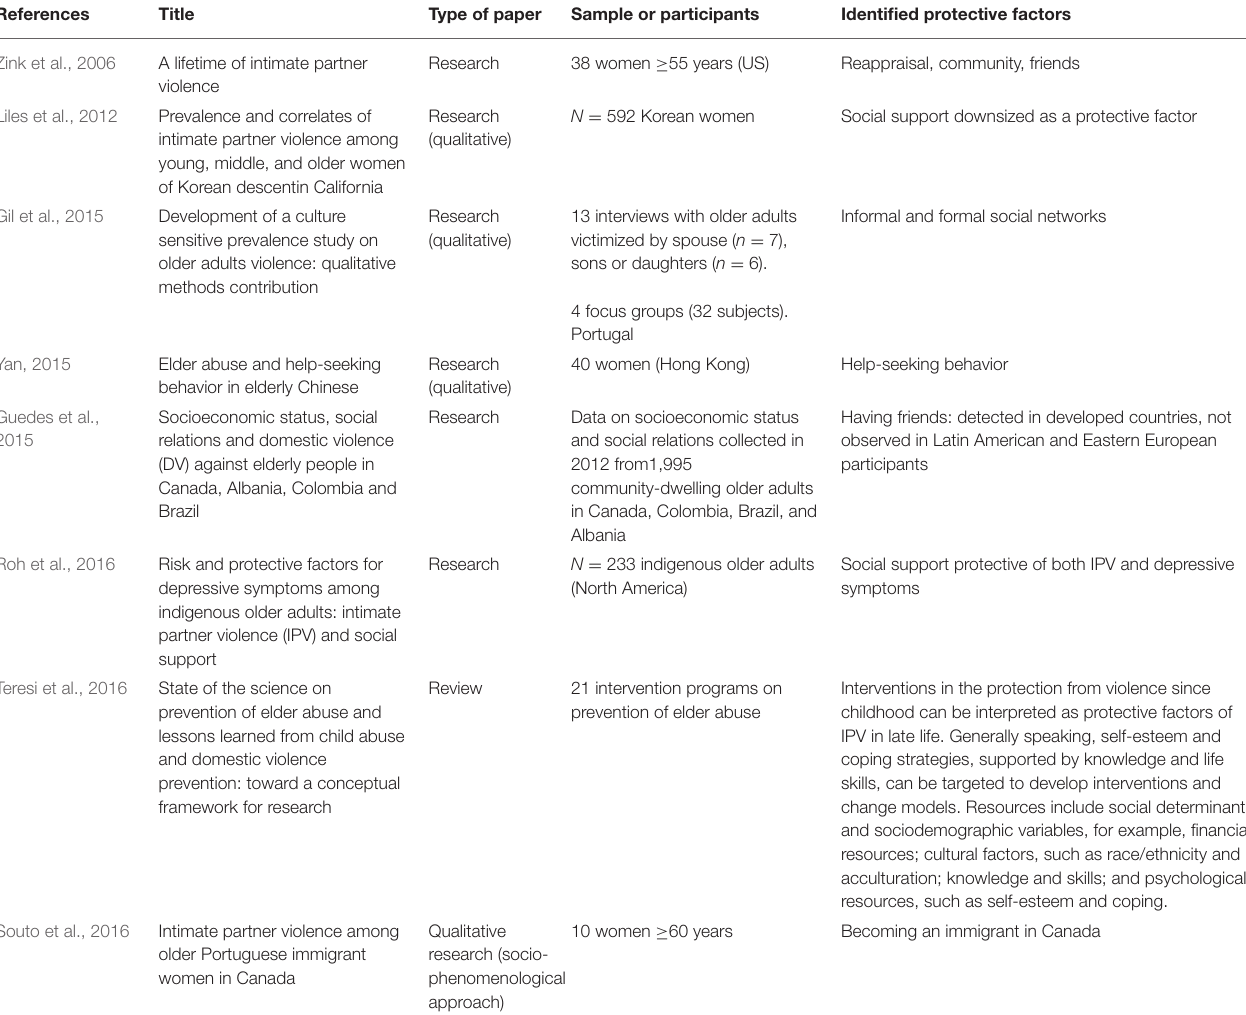
TABLE 1 | Published studies on protective